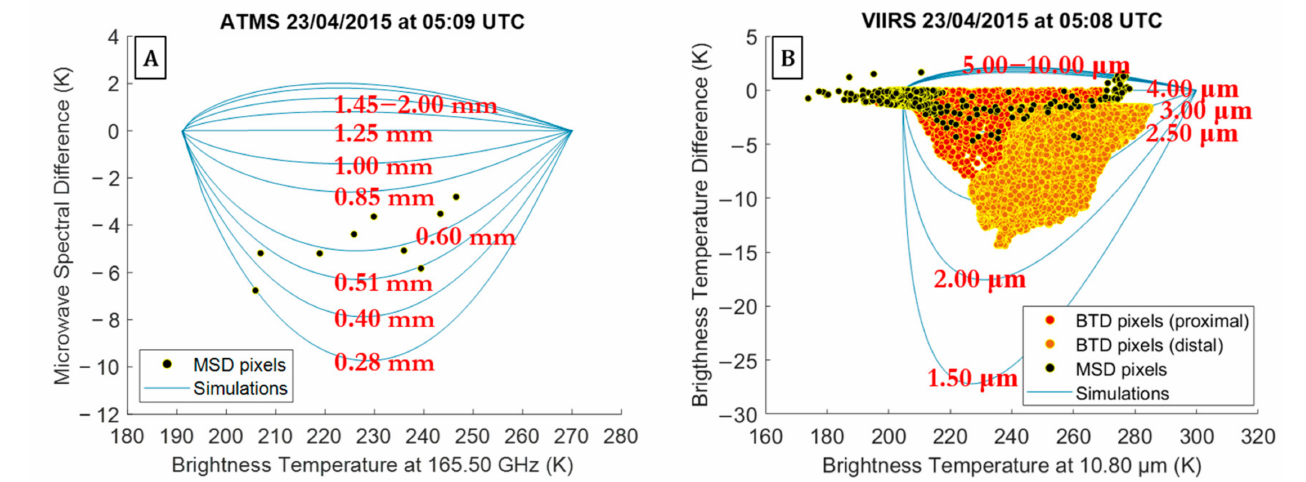
Figure 12. The Calbuco eruption on 23rd April 2015. ( A ) The simulated arch curves for MW-MMW observation. ( B ) The simulated arch curves for TIR observation. The black points represent ash pixels identified using the MSD method. The orange points highlight the fraction of pixels identified near the volcano by the BTD . The yellow points represent the ash pixels belonging to the first eruption (22 April 2015 at 21:08 UTC) identified by the BTD as